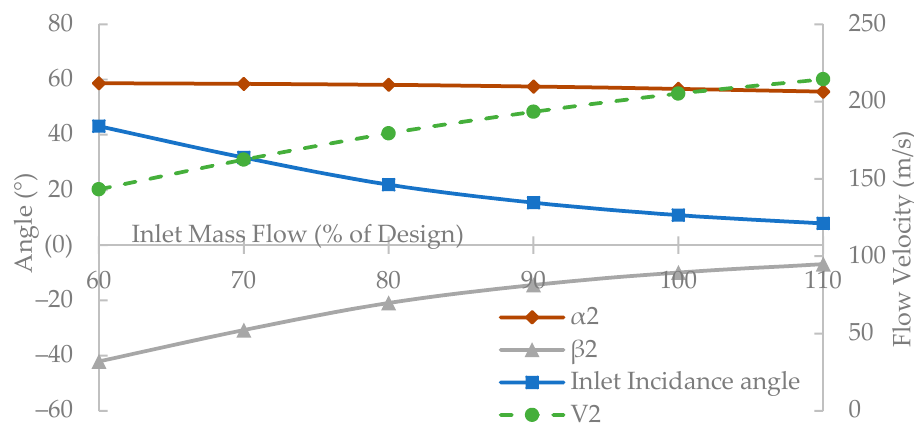
Figure 8. Evolution of inlet flow angles and inlet absolute velocity with varying mass flow rate.